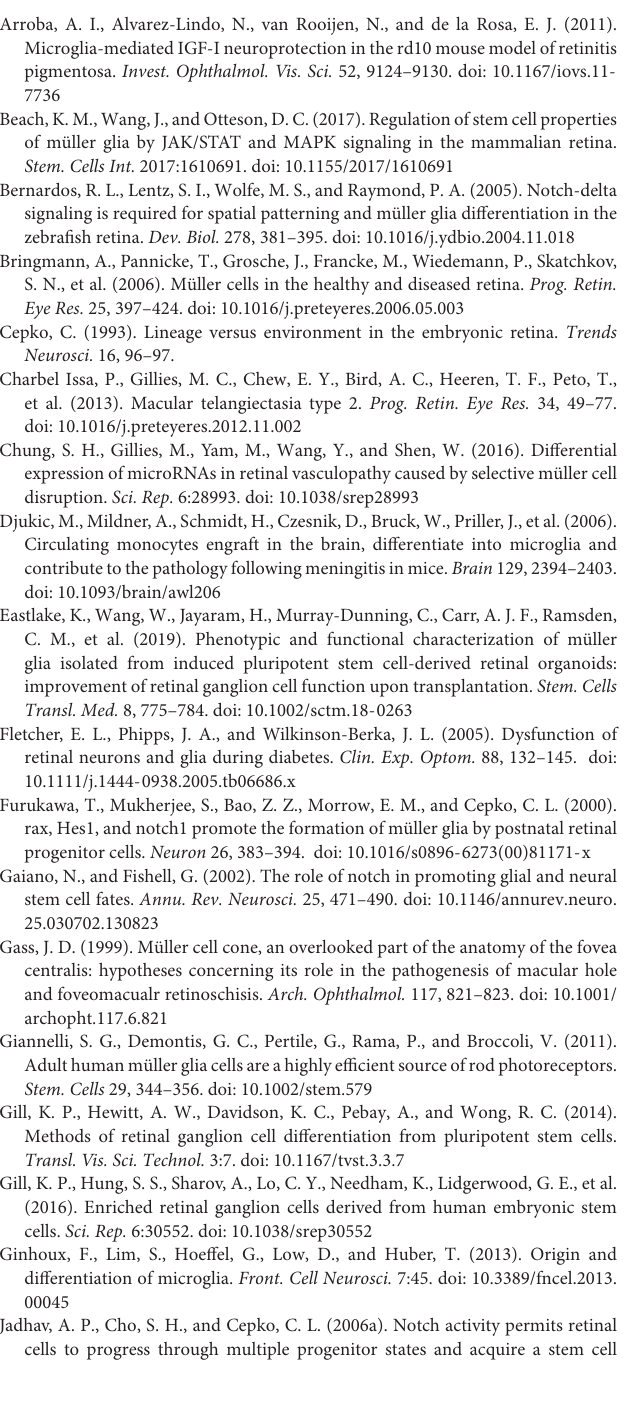
FIGURE S3 | qPCR analysis of Notch downstream effector genes 6 weeks after Notch stimulation in RPCs. We found decreased expression of Hes1 and Hes5 6 weeks after Notch promotion despite adding fresh Notch ligands every 2–3 days while changing media. Boxes represents the interquartile range, or the middle 50% of observations. The dotted line represents the median gene expression. Whiskers represent the minimum and maximum observations n = 3, p > 0.05.